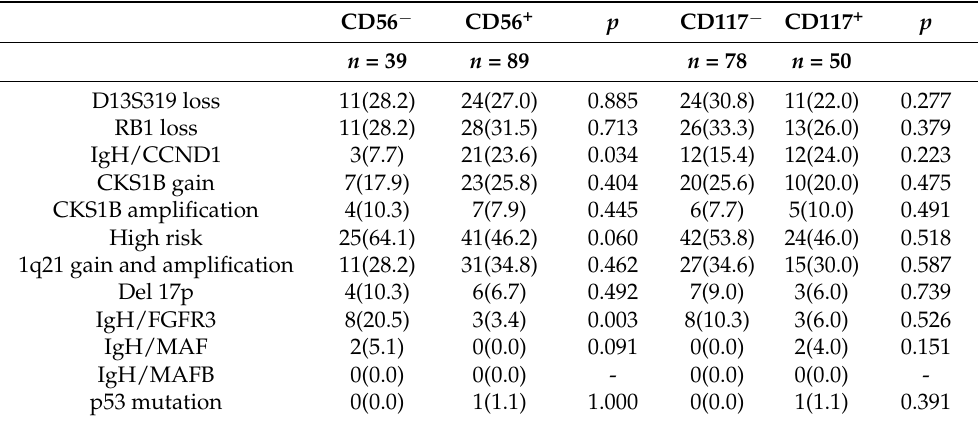
Table 2. Cytogenetic abnormality showed by CD56 and CD117 expression.